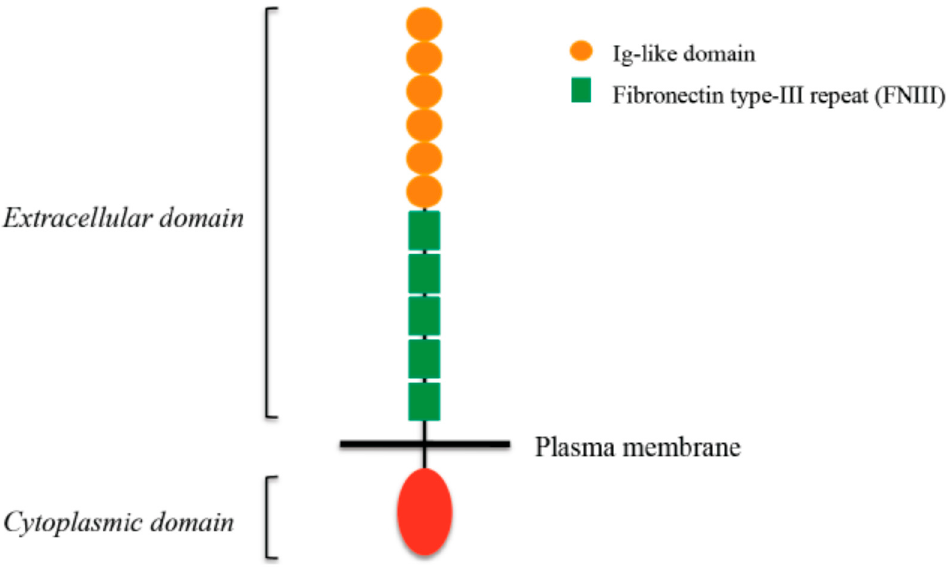
Figure 2. L1CAM structure. L1CAM is a cell adhesion molecule and is localized at the plasma membrane. It is composed by an extracellular portion that comprises six Ig-like domains (orange) and five fibronectin type III (FNIII) repeats (green), a short transmembrane domain, and a conserved cytoplasmic tail (red).